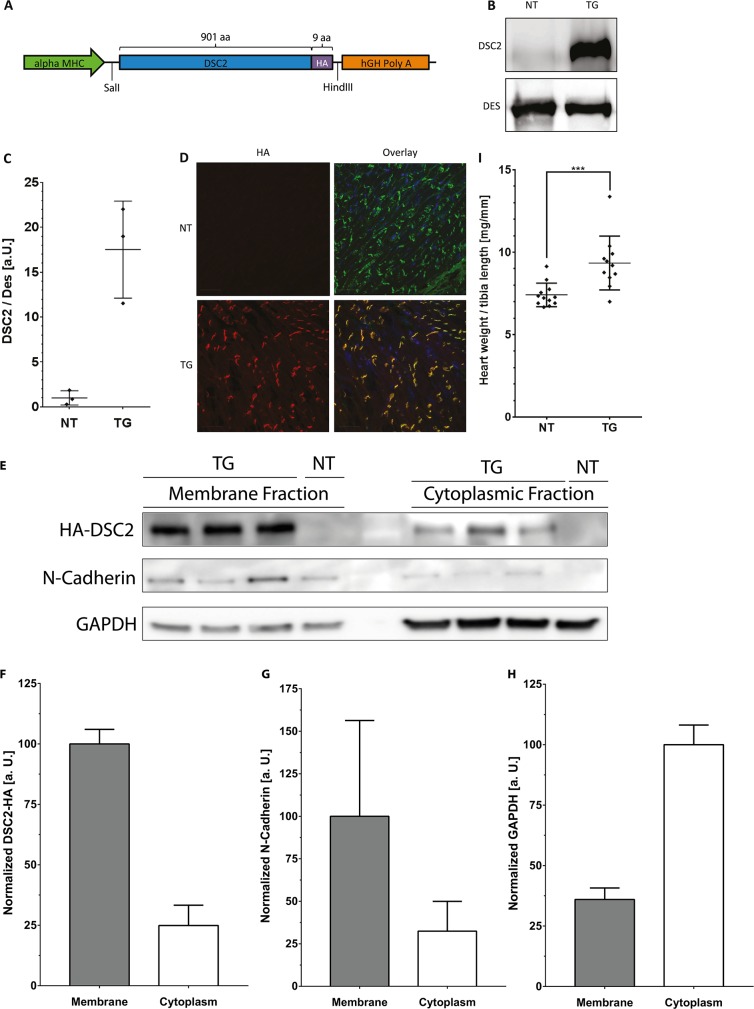
Generation and basic characterization of transgenic DSC2 mice.(A) Design of the construct for generation of DSC2 transgenic mice. (B) DSC2 protein expression analysis. The intermediate filament protein DES (Desmin, 55 kDa) was used for loading control. (C) Quantification of DSC2 protein expression reveals a ~17-fold overexpression of DSC2 in comparison to endogenous Dsc2 by using an antibody recognizing endogenous murine Dsc2 and exogenous human DSC2 (95 kDa, Progen, Heidelberg, Germany). Data represent mean ± SD; n = 3; DES = desmin. (D) Immunohistochemistry of myocardial tissue using anti HA- (red) and N-Cadherin (green) antibodies. Scale bars represent 20 μm. Of note, exogenous DSC2 and N-Cadherin co-localize (yellow). (E) Membrane and cytoplasmic fractionation in combination with Western blot analysis for DSC2-HA and N-Cadherin and GAPDH as controls for membrane and cytoplasmic proteins. (F-H) Normalized quantification of membrane fraction of DSC2-HA (F), N-Cadherin (G) and GAPDH (H). (I) Heart weight / tibia length ratio of transgenic and non-transgenic mice (13 weeks), n = 12. Statistical analysis was performed by non-parametric Kruskal-Wallis test (***p<0.001).